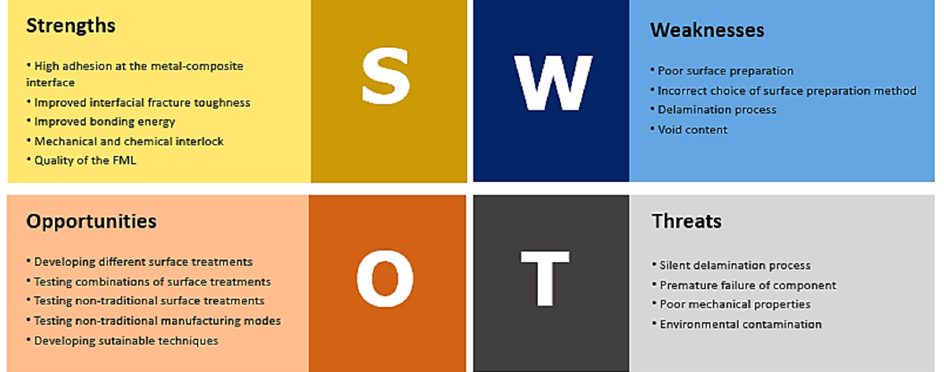
Figure 16. SWOT analysis showing the impact of surface treatment on the adhesion of dissimilar materials during the production of FML stacks.